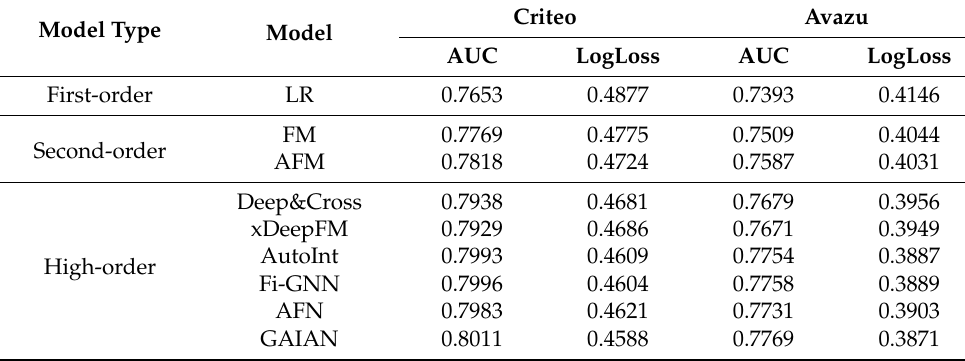
Table 2. Performance comparison of different